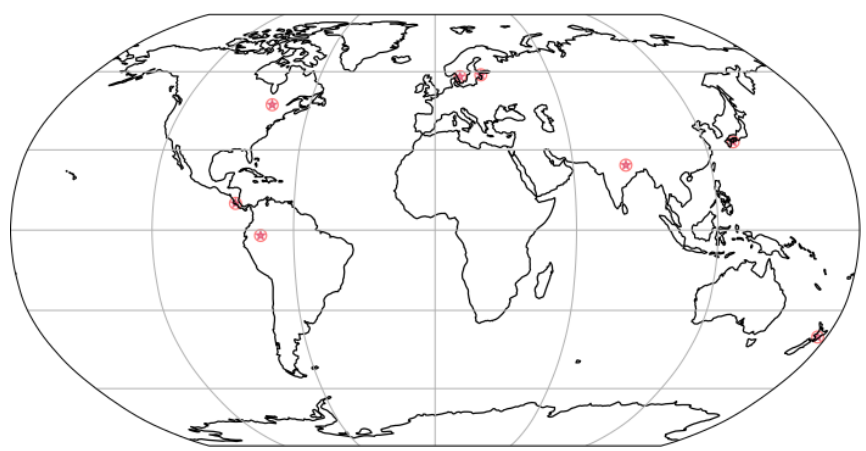
Figure 3. The locations used for the simulations are found in the following regions: United States of America (USA) [47 ◦ N 78 ◦ W], Costa Rica (CR) [10 ◦ N, 85 ◦ W], Sweden (Swe) [58 ◦ N, 13 ◦ E], Estonia (Est) [58.75 ◦ N, 24 ◦ E], Japan (Jap) [33 ◦ N, 133 ◦ E], New Zealand (NZ) [40 ◦ S, 176 ◦ E], Peru [2 ◦ S, 74 ◦